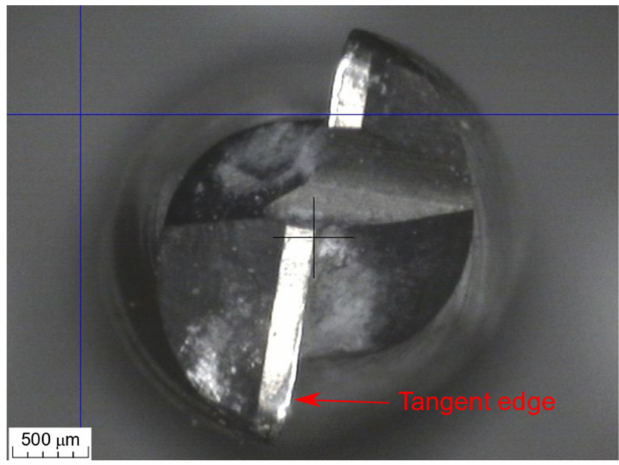
Figure 5. Tool wear after machining operations. Table 2. Relative deviation of specific cutting energy between two slotting tests with the same cutting parameters. V c (m /